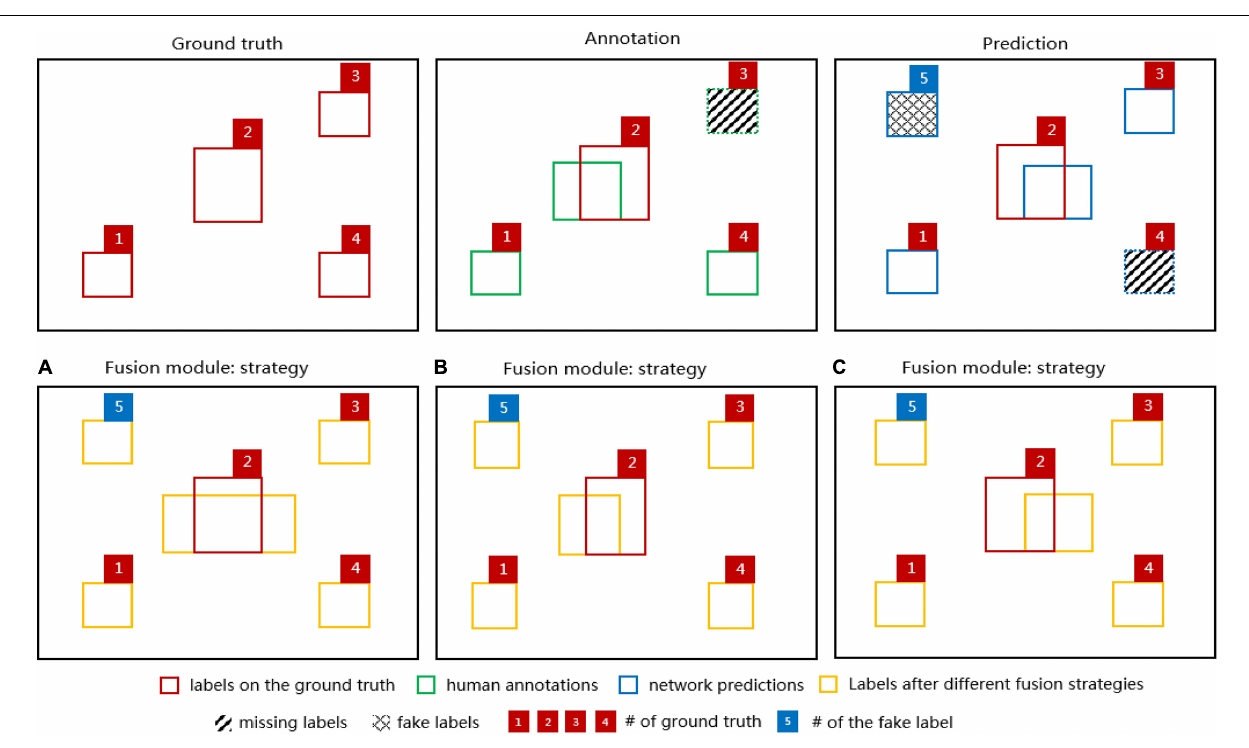
FIGURE 5 | Diagrams of 4 segmentation labels of the ground truth (red boxes), the corresponding annotation (green boxes) and the network prediction (blue boxes) in the upper row. For demonstration purposes, there is a missing label in the annotation (green dashed-line box numbered 3) indicating human errors and a missing label (blue dashed-line box numbered 4) and a fake label (blue crossing-line box numbered 5) in the network prediction indicating network errors. In the lower row, the fusion module output (orange boxes) based on the diagrams above is shown for the fusion strategy (A) , (B) , and (C) . Note that one of the ground-truth labels (red box numbered as 2) has been added to each diagram to indicate the discrepancies between the ground truth and various